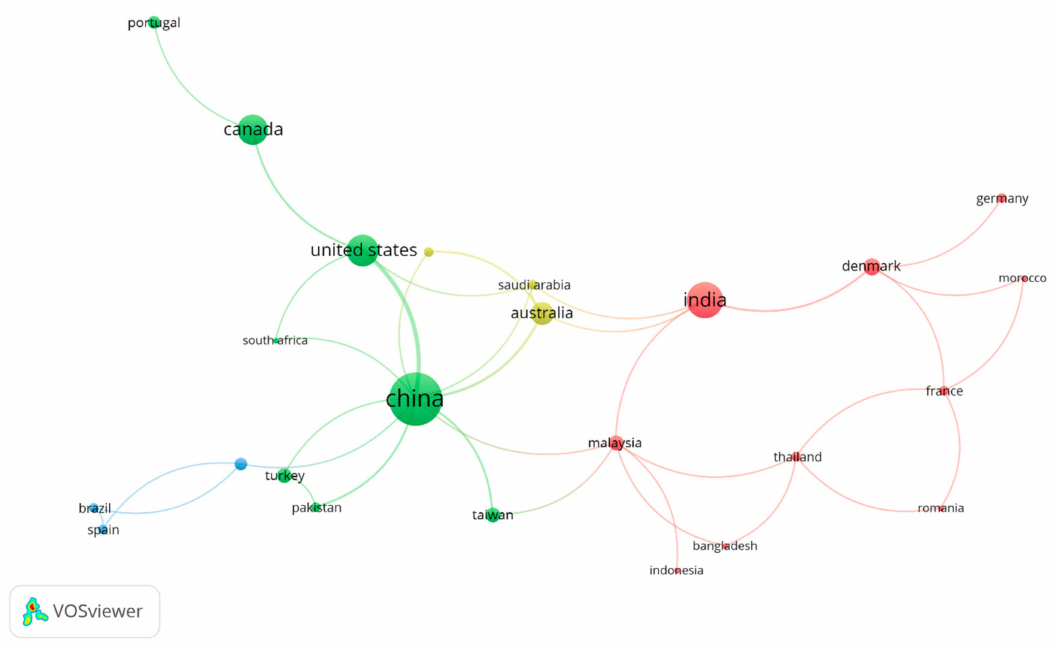
Figure 12. Graphical representation of top ten countries that dominate the EMSs for EV